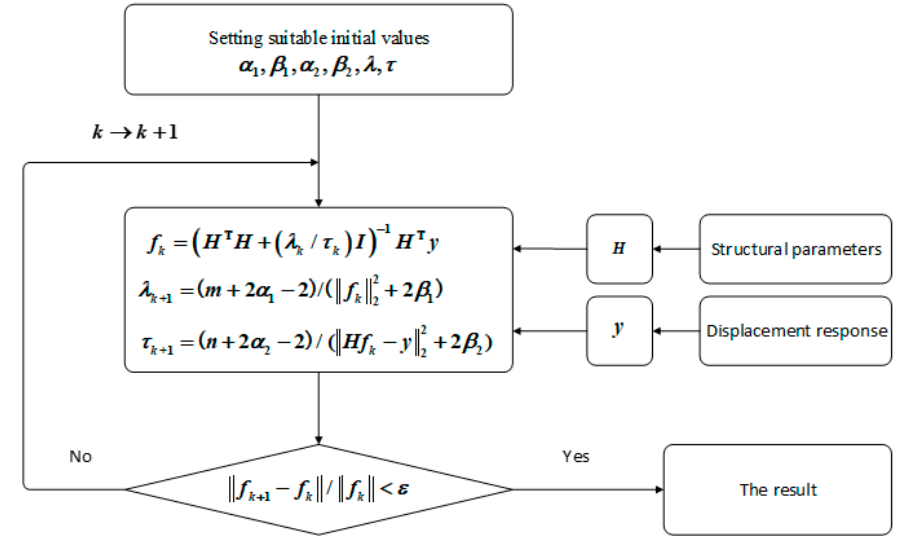
Figure 1. Load identification flow chart.